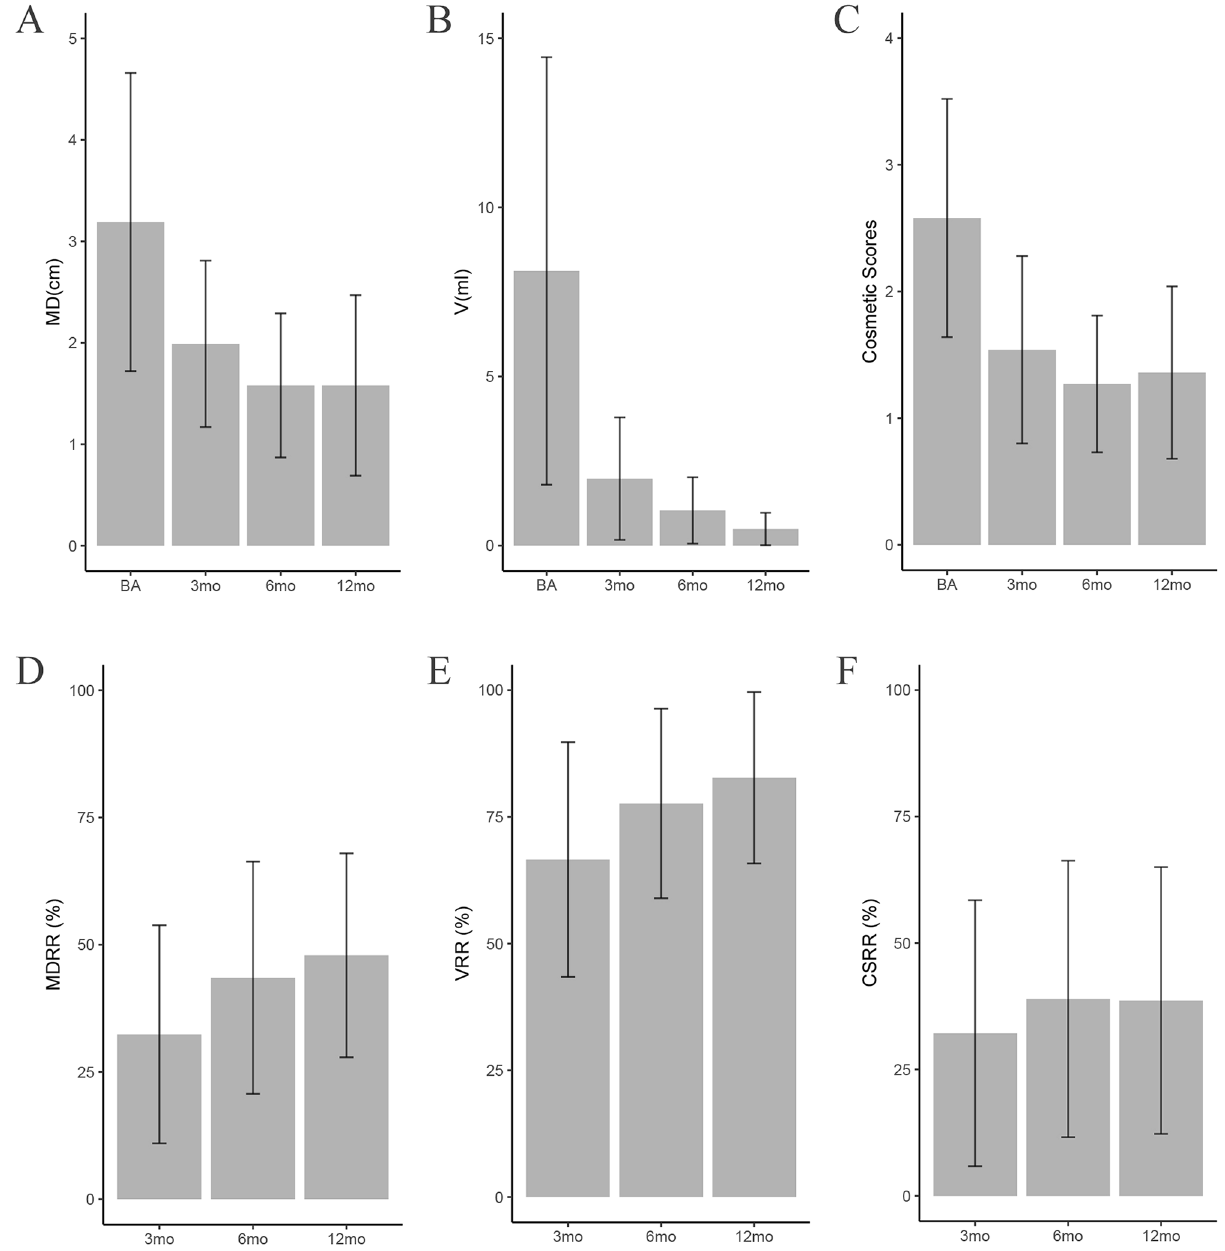
Figure 5. The comparison of the ablated nodular MD/V/CS/MDRR/VRR/CSRR in the cystic-solid nodule group at each follow-up. ( A ) The comparison of maximal diameter in the C_ group. ( B ) The comparison of volume in the C_ group. ( C ) The comparison of cosmetic scores in the C_ group. ( D ) The comparison of maximal diameter reduction ratio in the C_ group. ( E ) The comparison of volume reduction ratio in the C_ group. ( F ) The comparison of cosmetic scores reduction ratio in the C_ group. Means ± SD are presented. p < 0.05 was considered to indicate statistically significant difference ( MD maximal diameter, V volume, CS cosmetic scores, MDRR maximal diameter reduction ratio, VRR volume reduction ratio, CSRR cosmetic scores reduction ratio, C_ cystic-solid nodule group, BA baseline, mo